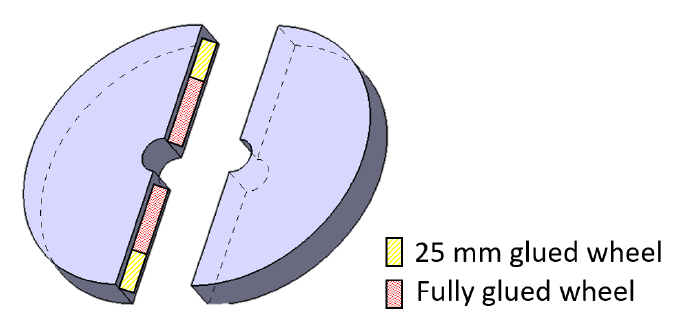
Figure 3. Glued segments of the grinding wheel.